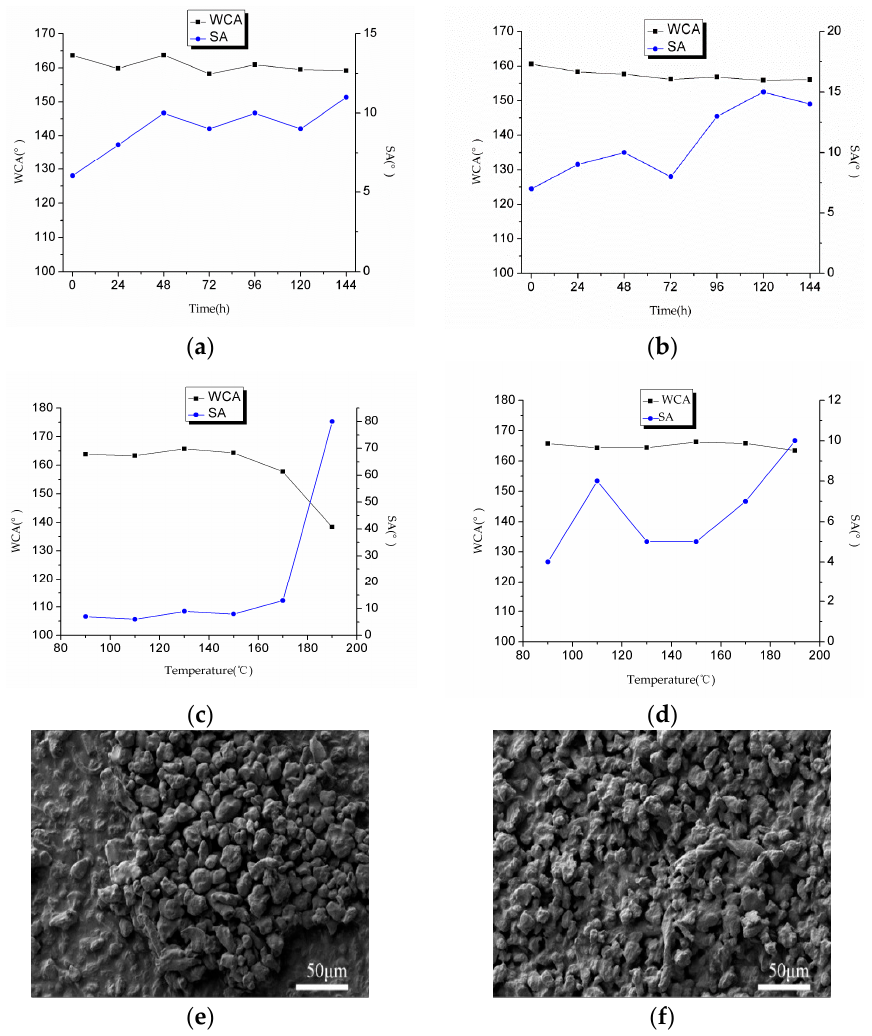
Figure 7. Change curves of the WCA and SA of ( a ) the D coating and ( b ) the E coating when exposed to UV radiation; change curves of the WCA and SA of ( c ) the D coating and ( d ) the E coating at different temperatures; surface morphologies of ( e ) the D coating and ( f ) the E coating after being fired with an alcohol burner for 1 min.